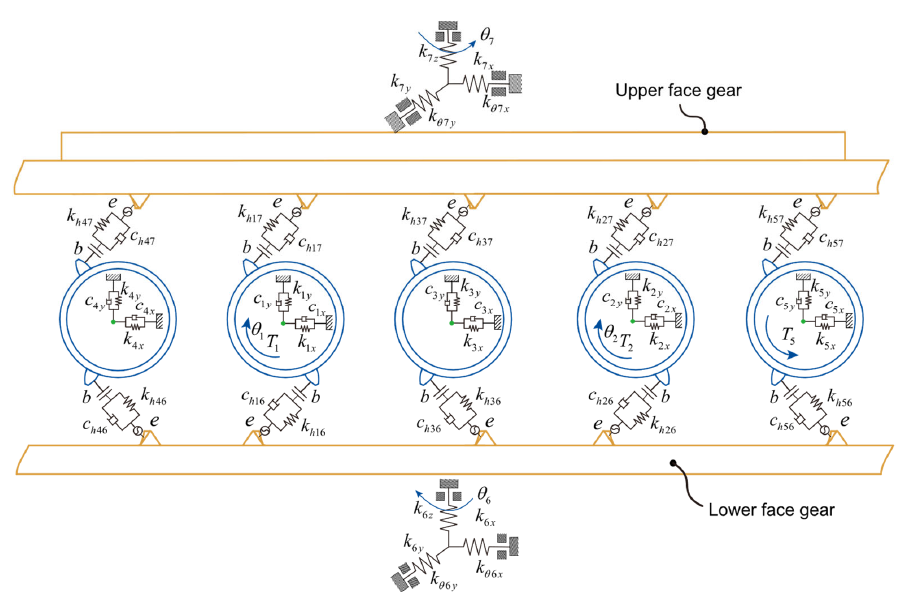
Figure 10. Distribution of face gears.